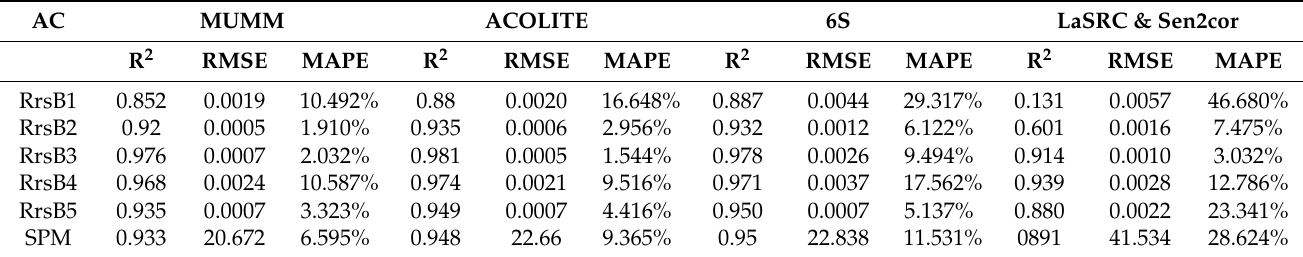
Table 2. Comparison of Rrs and SPM values from OLI and MSI images under different atmospheric correction